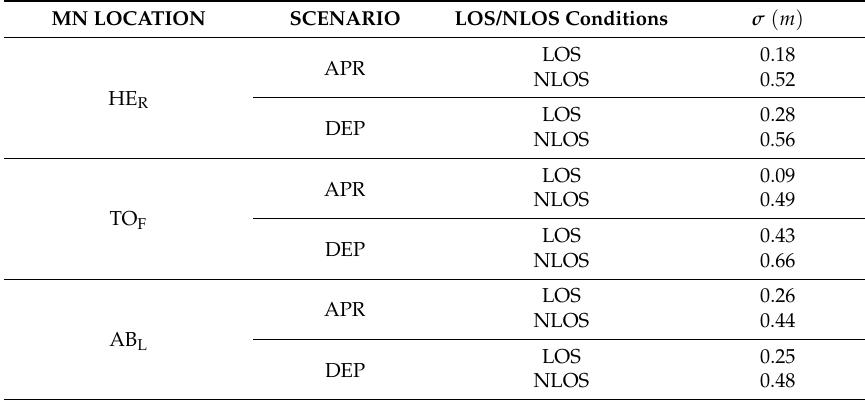
Table 2. Values of the standard deviation of a normal distribution of the distance estimation error fitted to the empirical values for all the measurement scenarios.